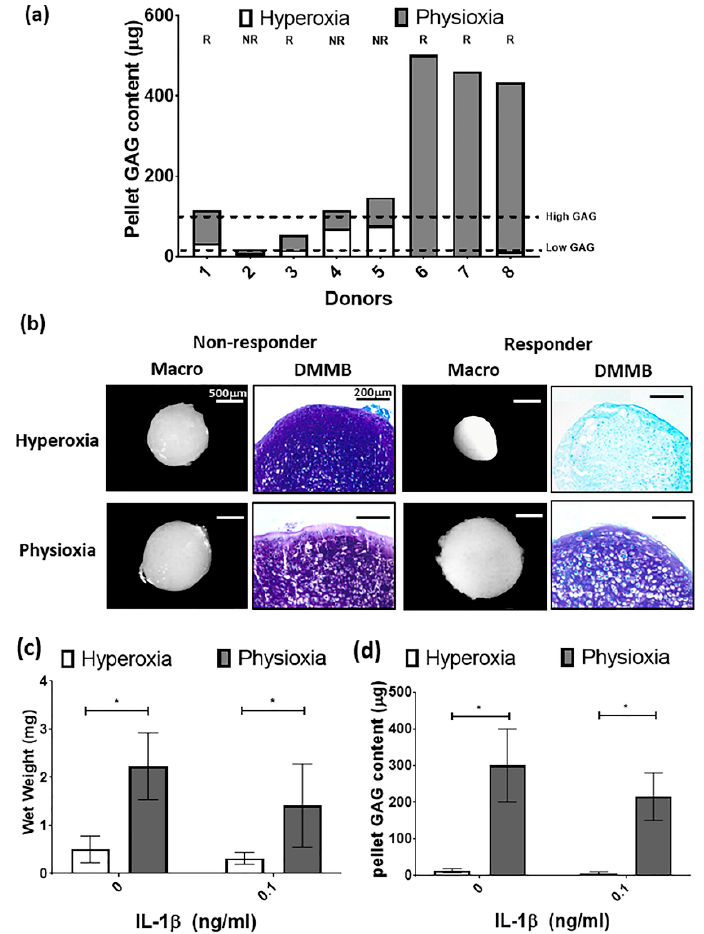
Figure 5. ( a ) Pellet GAG content under physioxia and hyperoxia for chondrogenic pellets. Dotted lines represent threshold for high (physioxia non-responsive) and low (physioxia responsive) GAG donors. R represents physioxia responders and NR are physioxia non-responders. ( b ) Representative macroscopic and DMMB stained chondrogenic pellets of physioxia non-responder and responder pellets. Pellet ( c ) wet weight; and ( d ) GAG content for physioxia responders with or without the presence of IL-1 β . Data represent mean ± S.D.; n = 5. * p < 0.05.